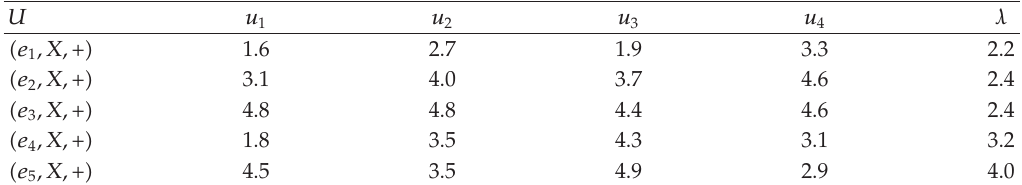
Table 7: Simplified accepted opinions of